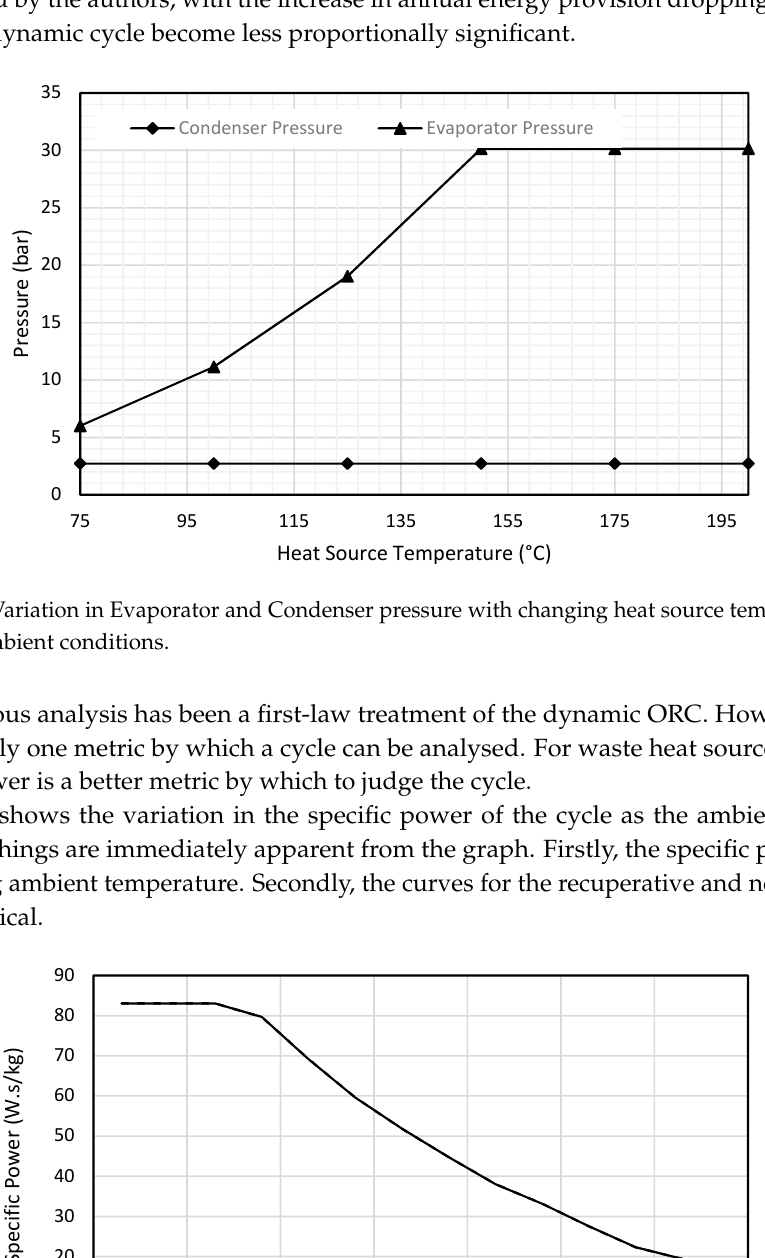
Figure 12. Evaporator Pinch Point Diagrams for a heat source temperature of 100 °C and heat sink temperatures of − 11 °C ( left ) and 25 °C ( right ). The second point, the fact that the recuperative and non-recuperative curves are identical, can be explained by the fact that the pinch point in both cases is at the bubble point of the working fluid, and that the recuperator does not cause a phase change in the evaporator. Even though the energy transferred in the evaporator will be less in the recuperative case, meaning the first law efficiency increases, this does not necessarily translate into an increase in specific power, as the expander work is still held constant, and the thermal fluid line must still satisfy the pinch point condition. This means that unless the pinch point position changes, there can be no change in the flow rate on the hot side of the evaporator, and the specific power will not change. In no cases analysed was there a phase change in the recuperator, meaning that there was no difference between the recuperative and non- recuperative plots.